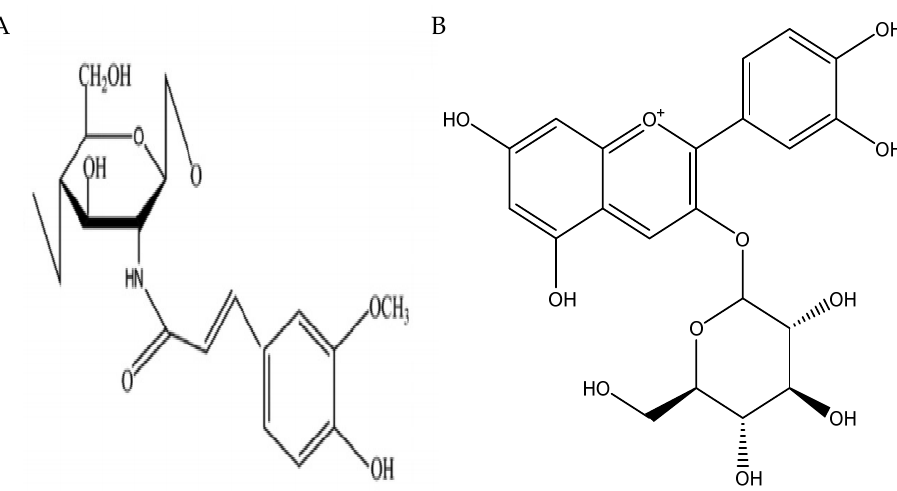
Figure 5. The structures of FA-g-CS ( A ) and ANC ( B ).